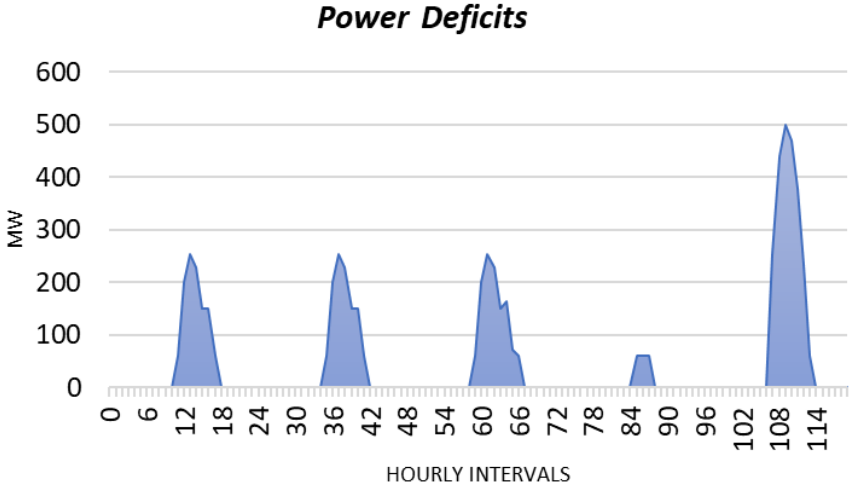
Figure 5. Power deficits applying the genetic algorithm mechanism.